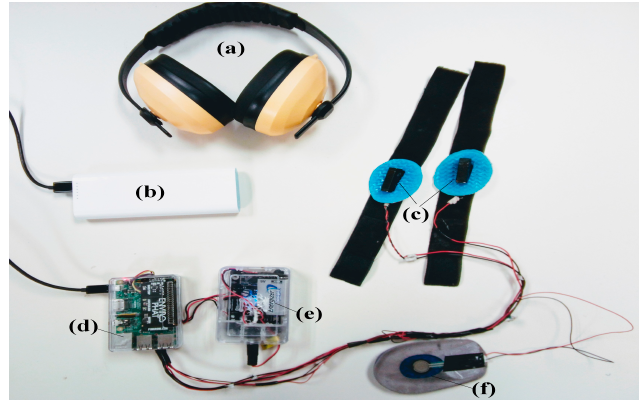
Figure 3. Enactive wearable and removable insole: ( a ) ear protection; ( b ) Power supply of 5 v; Haptic system (( c ) Mark II haptuator mounted on strap; ( e ) Bluetooth amplifier with a battery); Computing system (( d ) Raspberry Pi + EnviroPhat; ( f ) Force sensitive